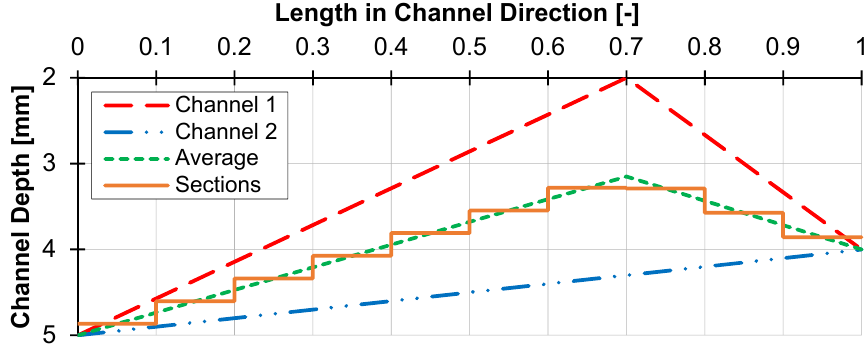
Figure 17. Average channel depth of a part of a wave-dispersion screw.